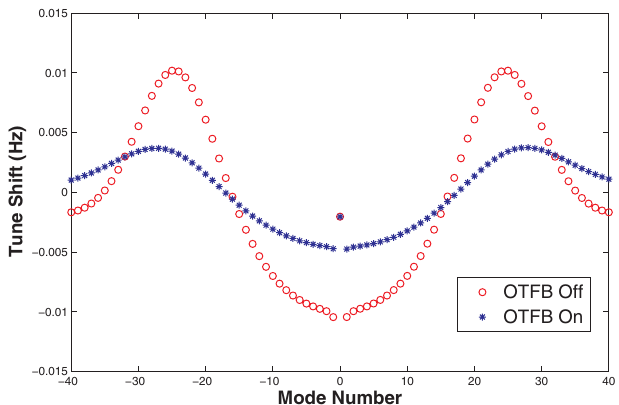
FIG. 8. (Color) Tune shift for configuration injection end 0.3 A with 1-Turn feedback (OTFB) on or